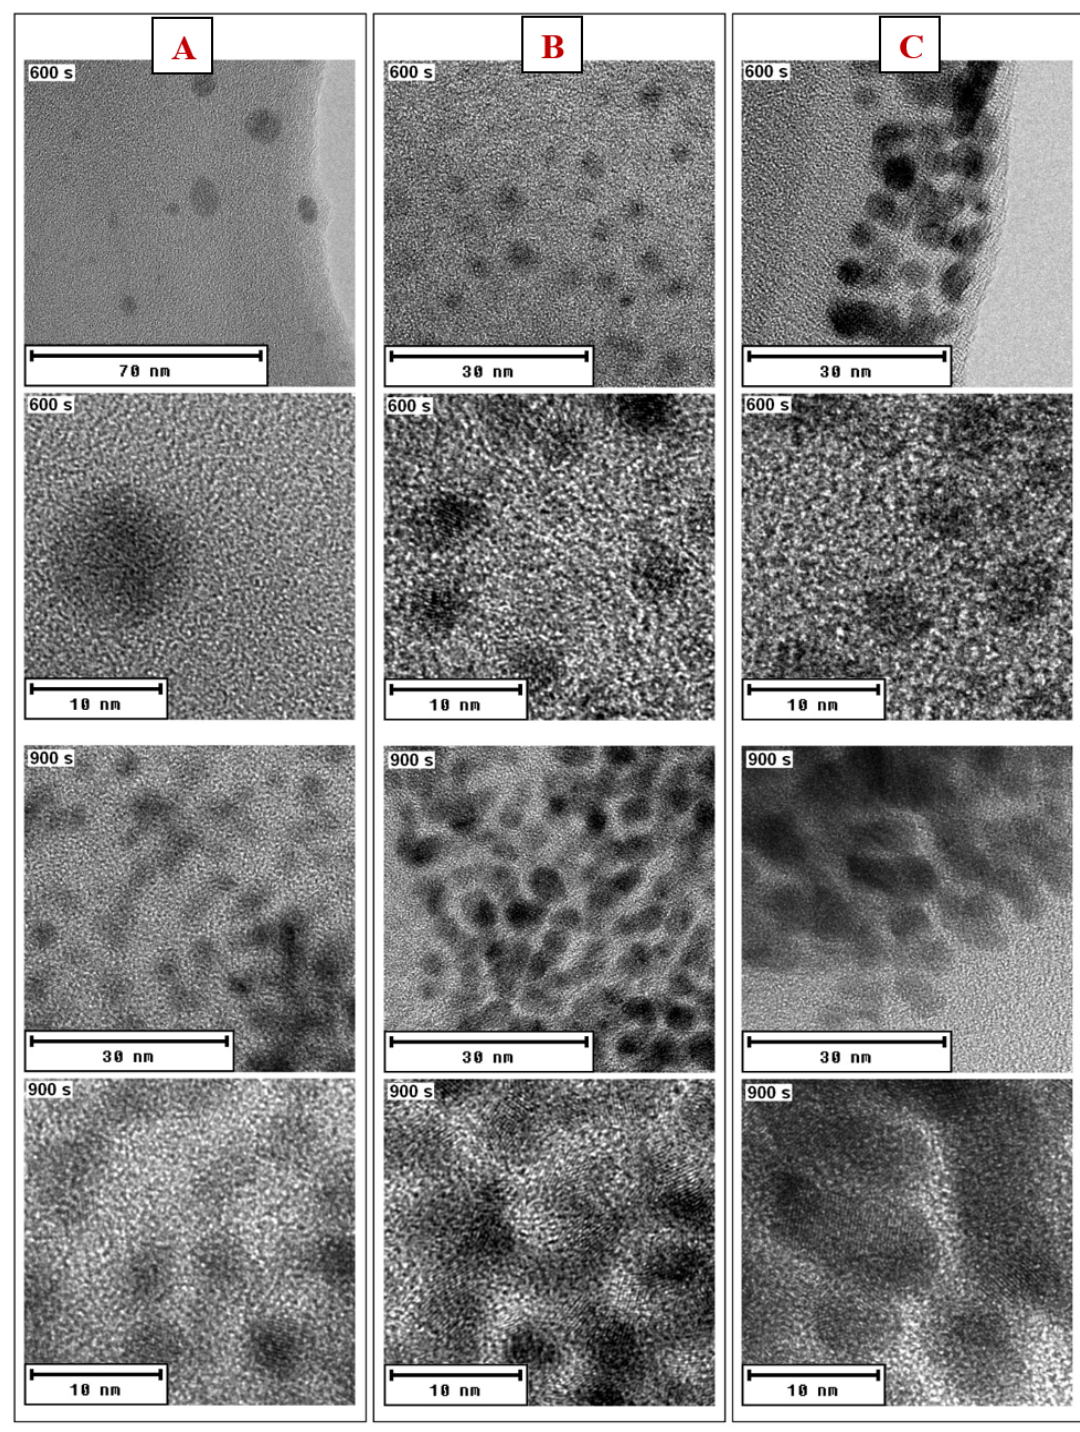
Figure 8. HRTEM AuNP images in PEG/NALC/H 2 O prepared with a deposition time of 600 or 900 s: ( A ) NALC/H 2 O solution (0.5 g/100 mL), ( B ) TCD/H 2 O solution (1.0 g/100 mL), and ( C ) TCD/H 2 O solution (1.5 g/100 mL).